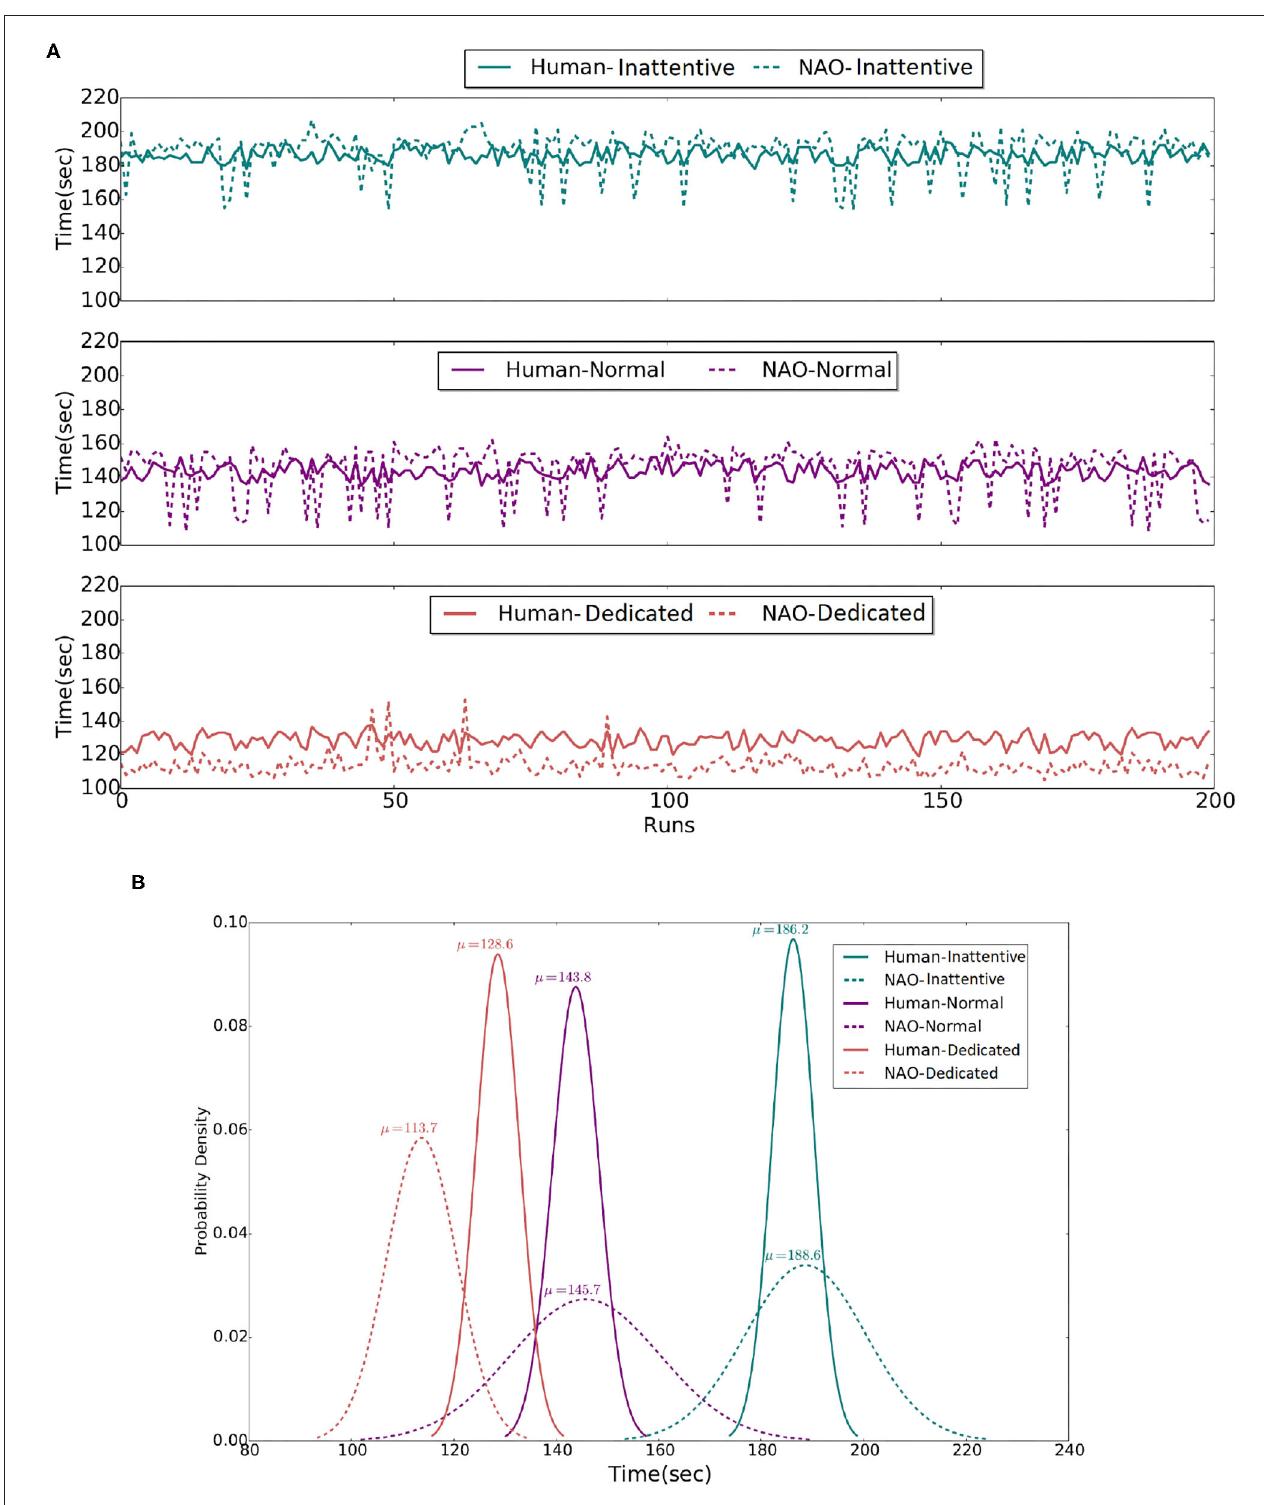
FIGURE 10 | (A) Actual times for Human-agent (lines) and NAO robot (dotted-lines) over 200 runs for the three groups. (B) Gaussian distributions of actual times for Human-agent (lines) and NAO robot (dotted-lines) over 200 runs for the three groups. Green, purple, and red lines indicate the Inattentive, Normal, and Dedicated group,